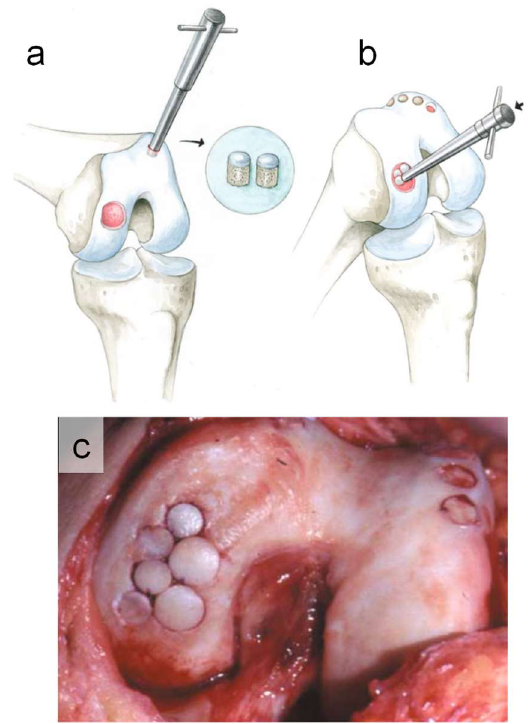
Figure 1. Illustration of OAT surgery technique showing ( a ) defect debridement and donor graft harvesting, ( b ) implantation of the donor grafts into the defect, and ( c ) picture of the bone showing donor grafts implantation into the defect. The figure is reproduced from ref. [16] .